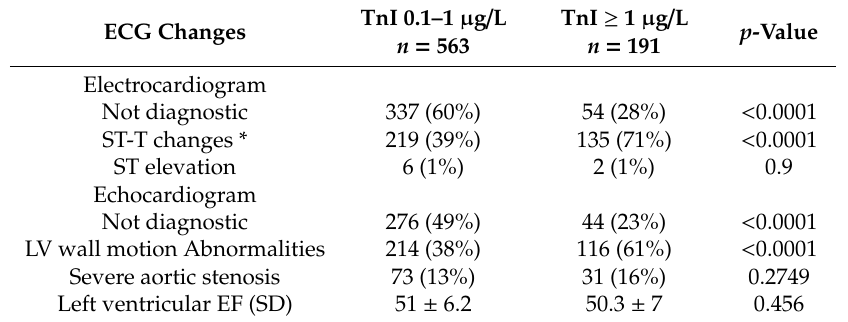
Table 2. ECG and echocardiographic abnormalities in relation to degree of troponin increase. ECG